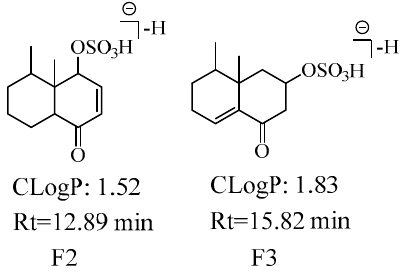
Figure 11. The possible structures of F2 and F3. The CLogP represents CLogP values, Rt represents retention